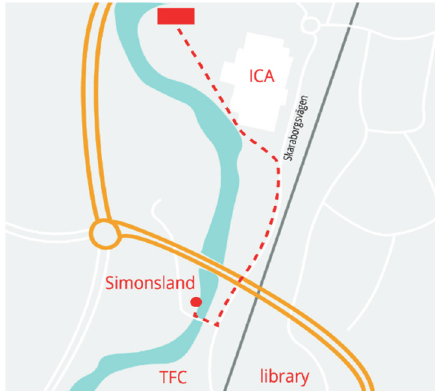
Figure 1. Simplified map of the study area. The student housing is called Simonsland. Textile fashion center (TFC) and the library indicate the positions of the university buildings. ICA is a supermarket. The red box represents the drop-off station, and the dotted line the shortest route from the student housing (500 m).